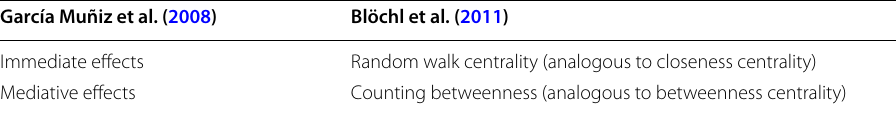
Table 1 Equivalency of measurements García Muñiz et al. (2008) Blöchl et al.